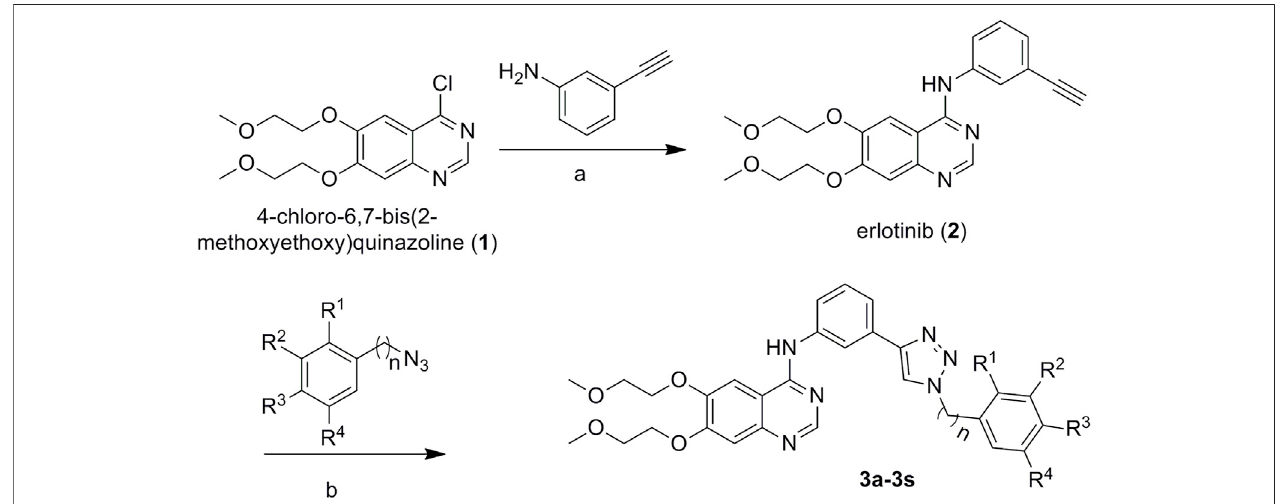
FIGURE 9 | Synthetic routes to erlotinib – 1,2,3-triazole derivatives. Conditions: (A) isopropanol alcohol, 85 ° C for 6 h, and (B) CuI, 80 °